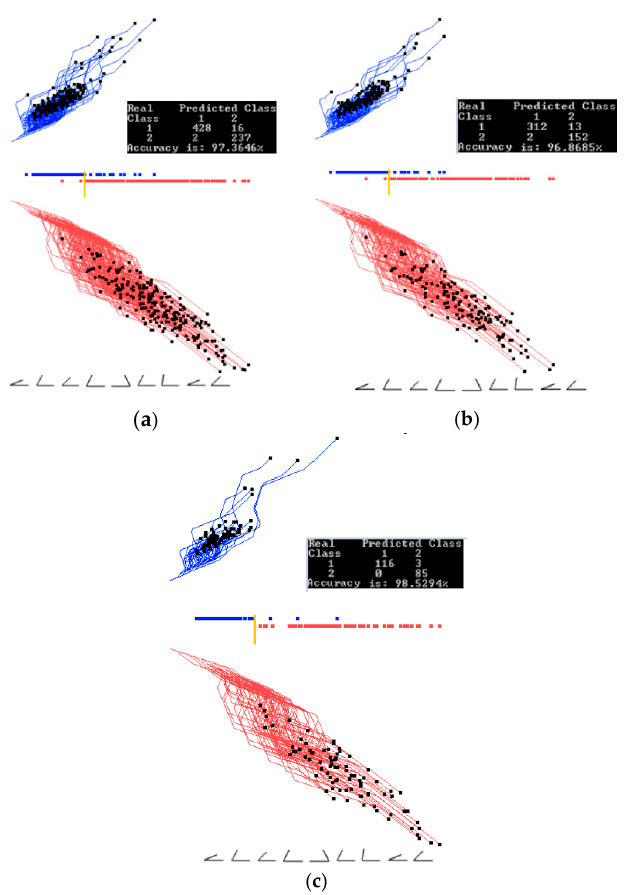
Figure 6. Results for the Wisconsin breast cancer data showing the training, validation, and the entire data set when trained on the entire data set. ( a ) Entire training and validation data set. Best projections of one of the first runs of GLC-AL. Coefficients found on the entire data set; ( b ) Data split into 70/30 (training and validation) showing only 70% of the data, using coefficients and the separation line found on the entire data set in (a); ( c ) Showing the 30% (validation set). Using the coefficients and the separation line same as in (a). Accuracy goes up.